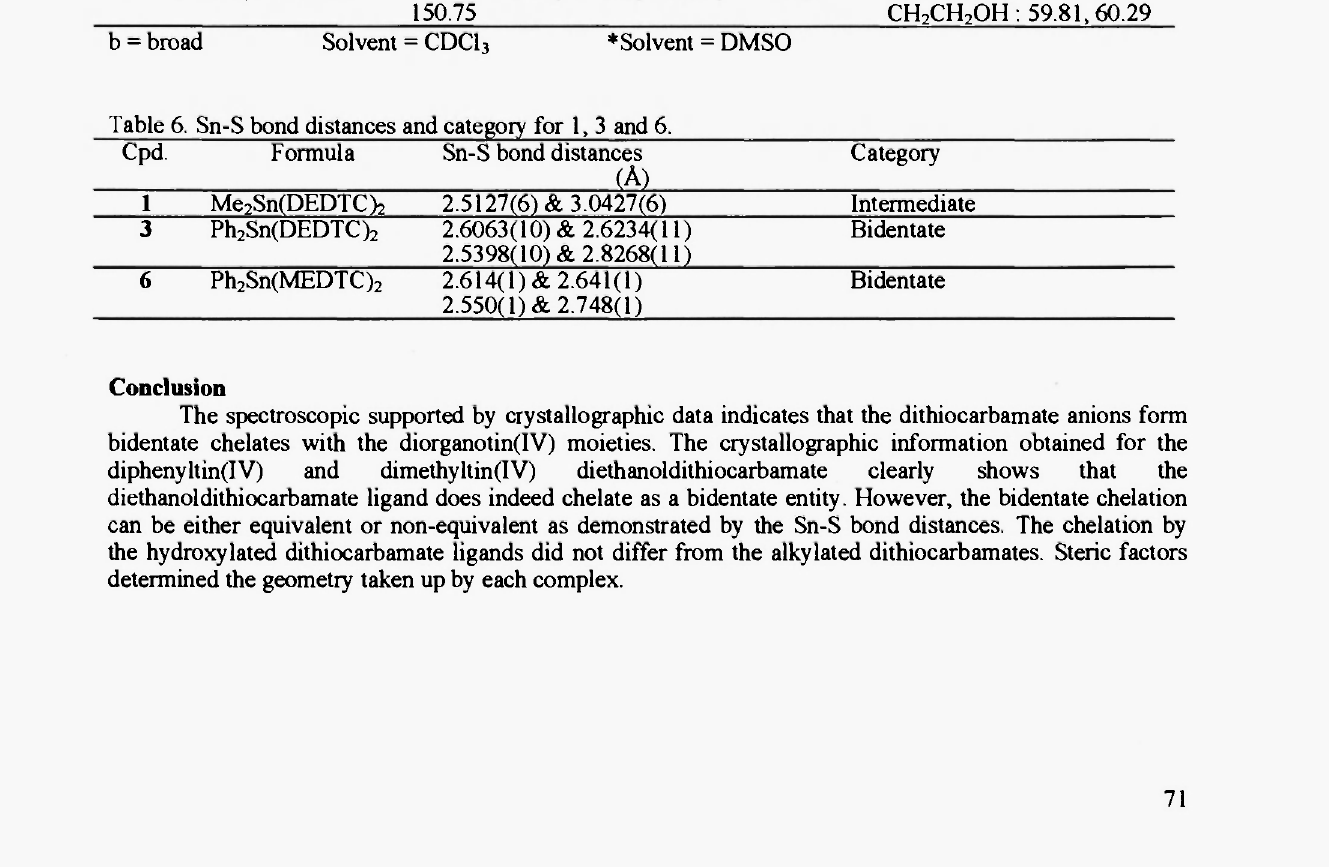
Table 6. Sn-S bond distances and category for 1 , 3 and 6.